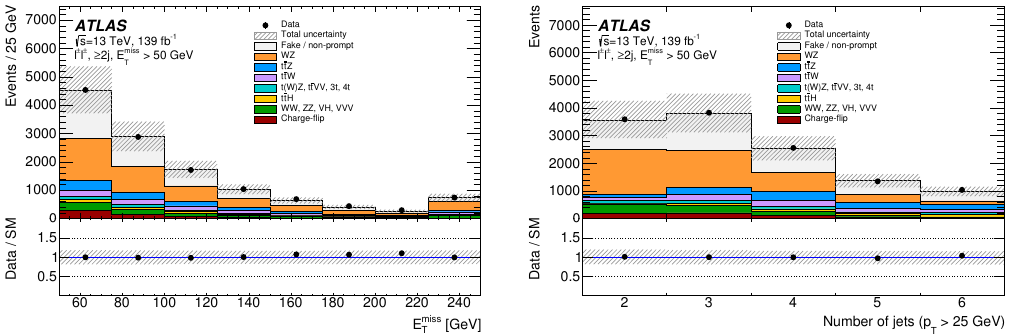
Figure 3. Distributions of (left) E miss and (right) the number of jets with p T > 25 GeV, after a T loose preselection requiring events with same-sign leptons, E miss > 50 GeV and at least two jets T with p T > 40 GeV. The uncertainties, shown with hashed bands, include the total uncertainties in the reducible background, as well as the modelling and statistical uncertainty for the Monte Carlo simulations. The last bin is